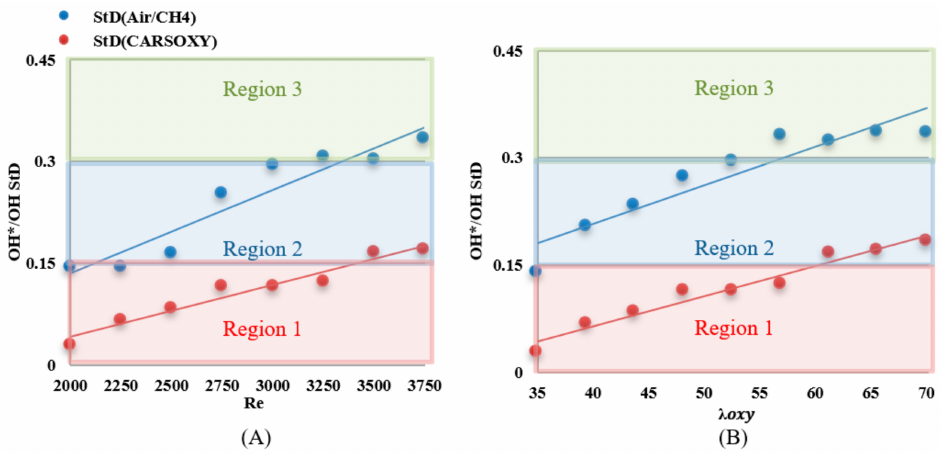
Figure 10. σ of CARSOXY and CH 4 /air over ( A ) working fluid Re = [ 2000 − 3750 ] at OH ∗ /OH . V CH4 = 1 L/min and ( B ) λ oxy = [ 35 − 70 ]